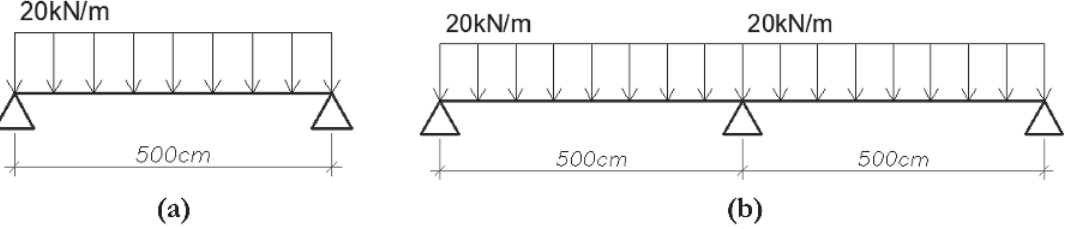
Calculation model of (a) Beam B1 and (b) Beam